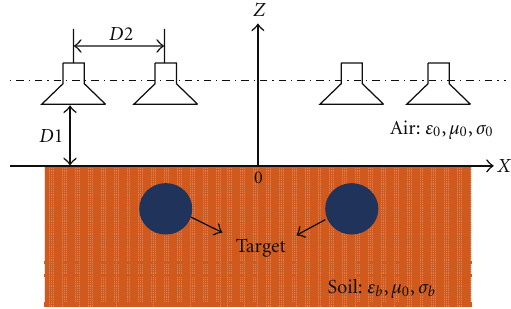
Figure 2: Geometry for multiobject subsurface